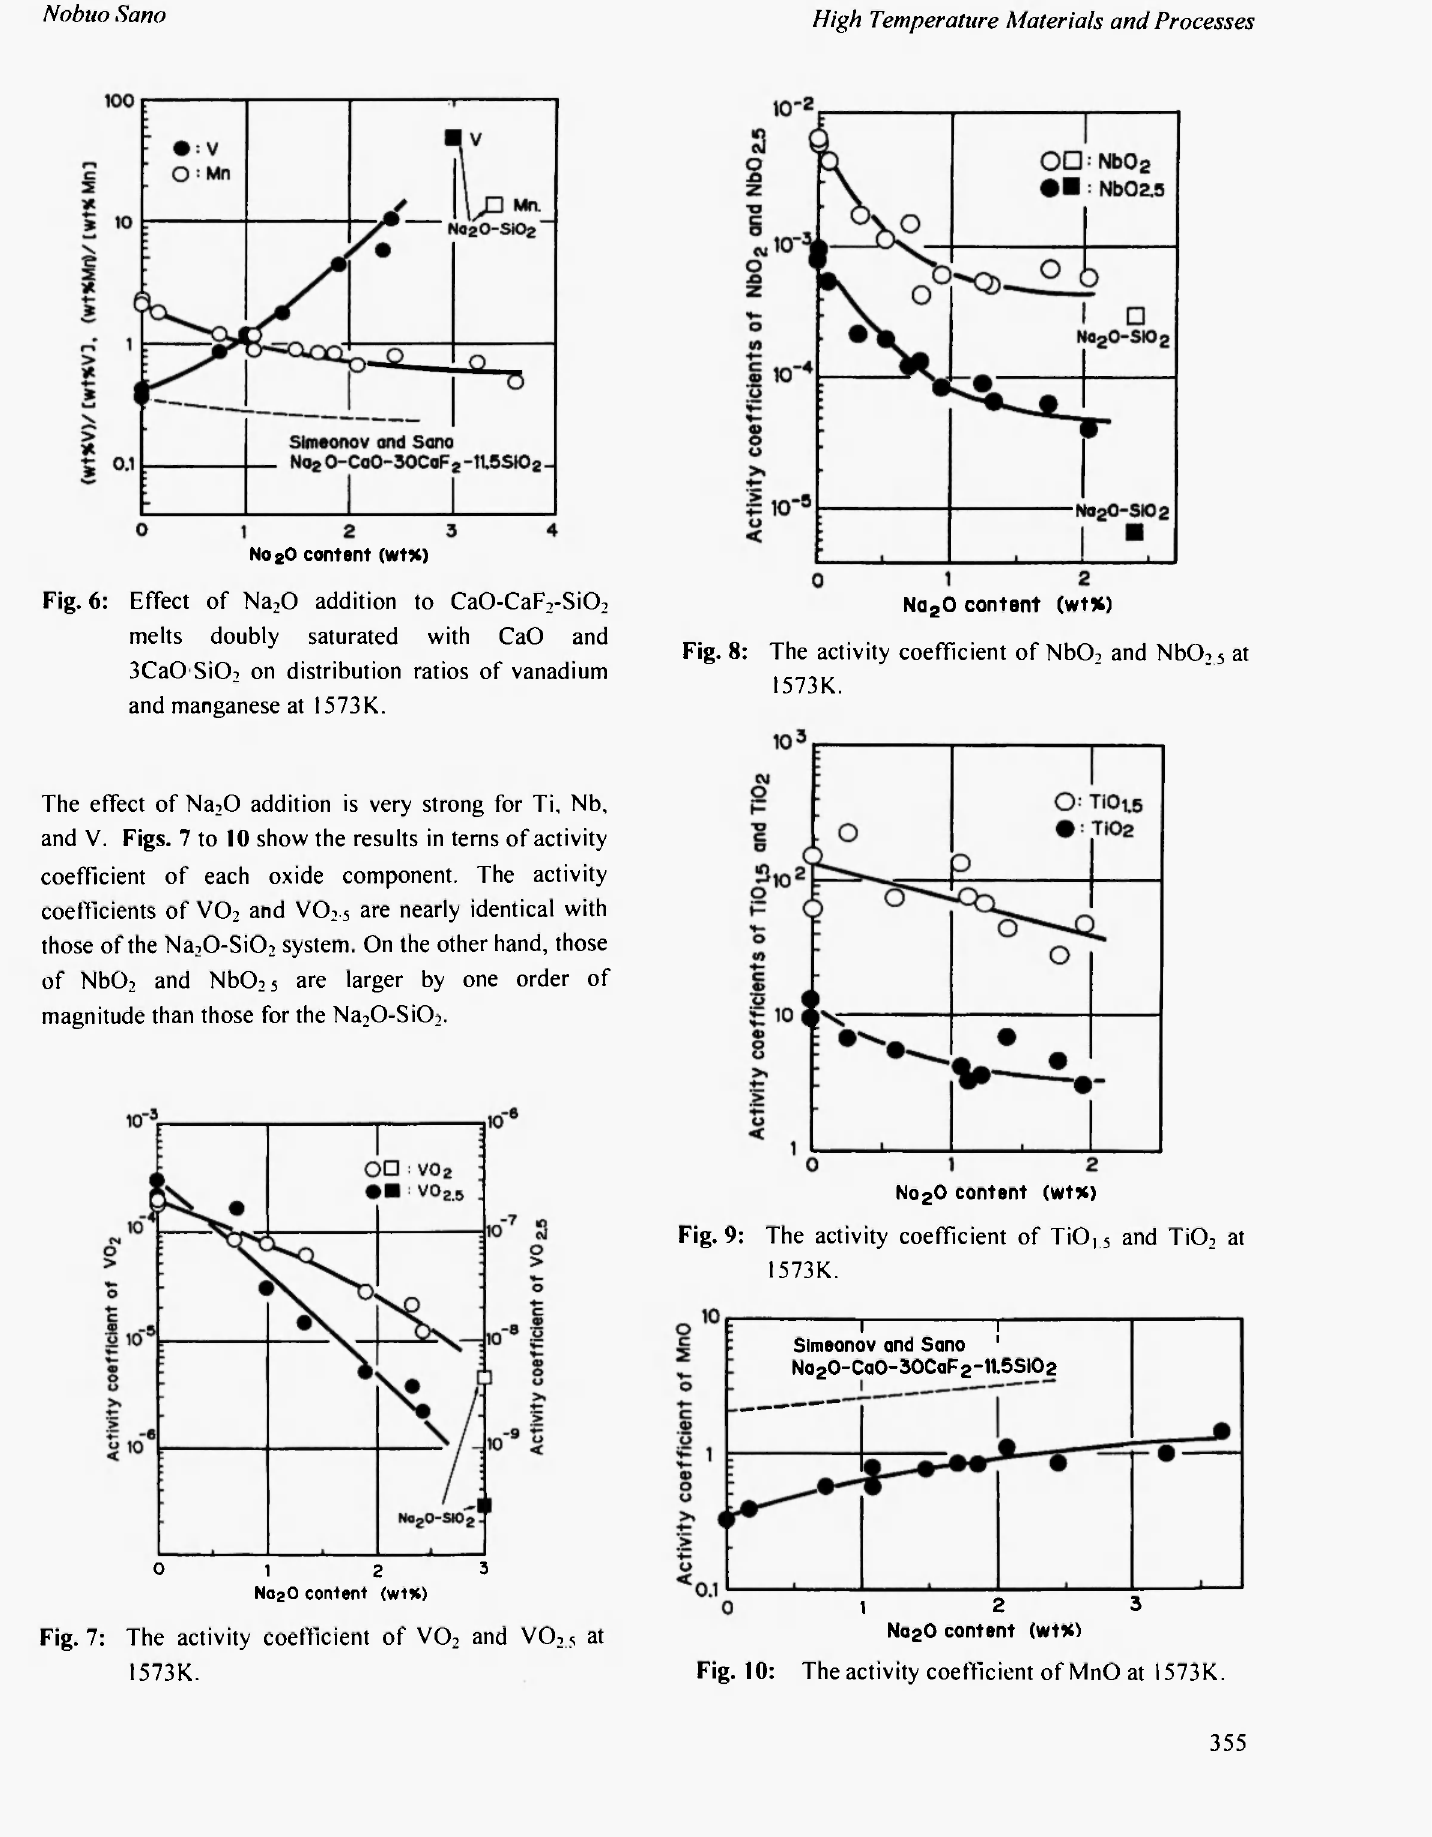
Fig. 7: The activity coefficient of V0 2 and V 0 2 5 at 1573K.